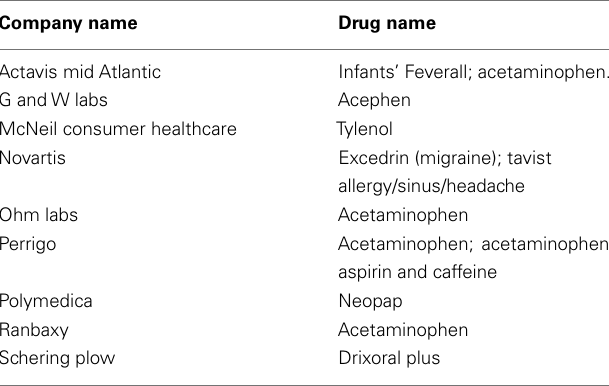
Table 2 | Over-the-counter drug products (OTC) containing